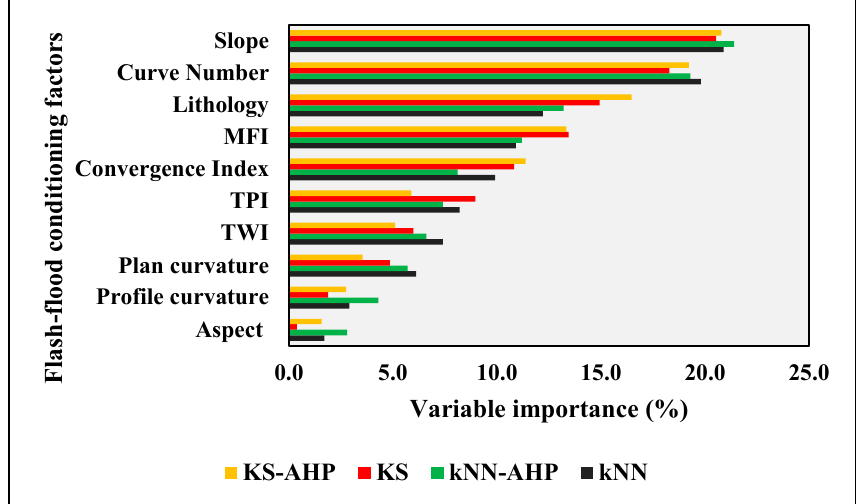
Figure 11. The importance of flash ‐ flood conditioning factors within FFPI models.